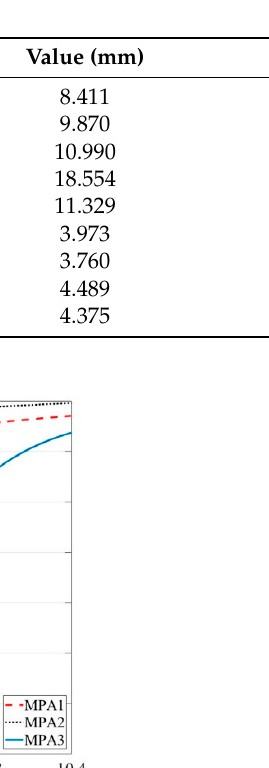
Figure 7. MPA3 configuration. Table 2. MPA3 geometrical parameters.